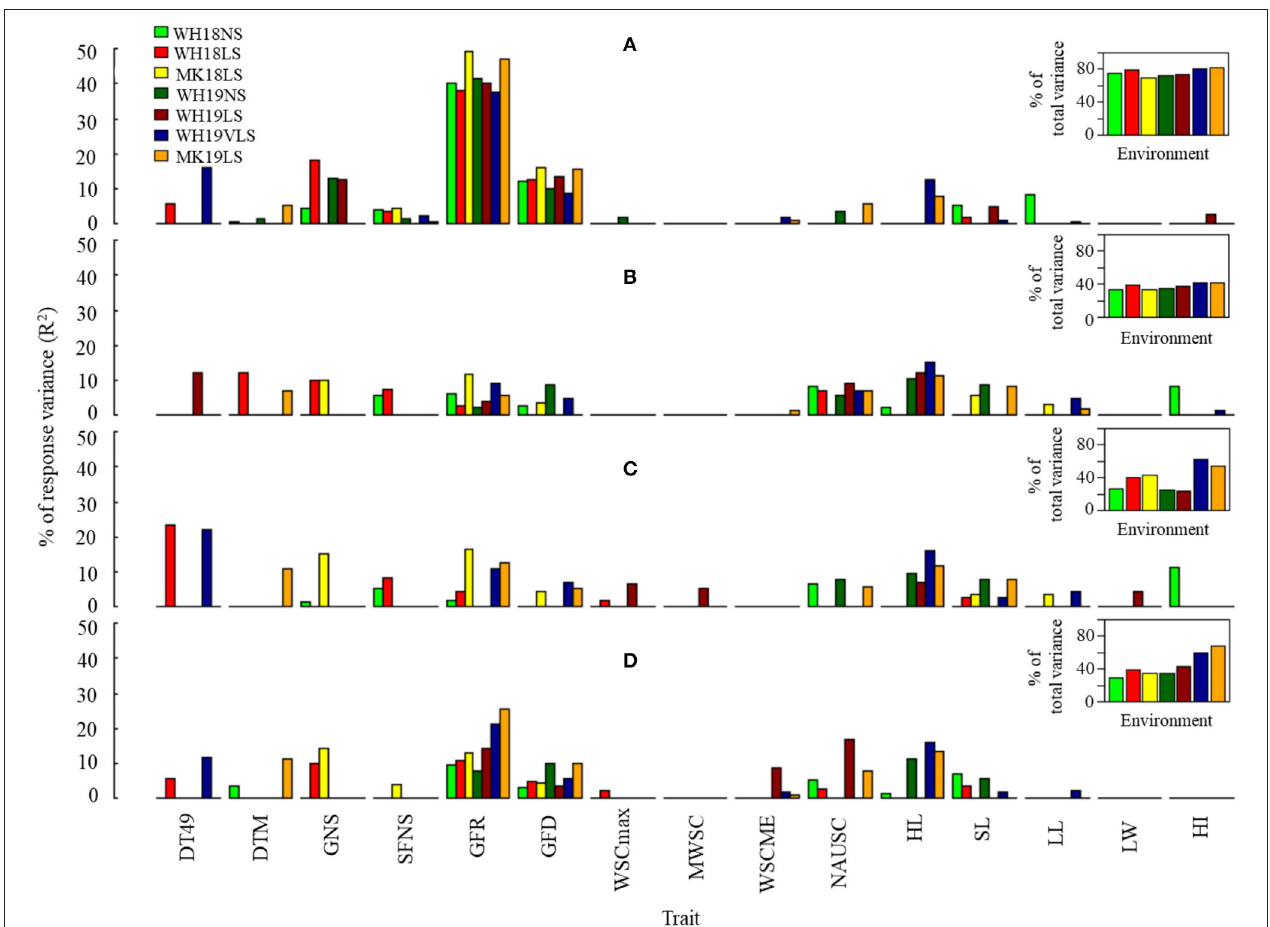
FIGURE 4 | Estimated contribution (% of variance, R 2 ) of selected phenological, agro-morphological and physiological traits to (A) TGW, (B) GP, (C) Ret, and (D) grain width (GWi) in WH18NS (light-green), WH18LS (light-red), MK18LS (yellow), WH19NS (dark-green), WH19LS (dark-red), WH19VLS (navy-blue), and MK19LS (orange) environments. Insets show the total variability explained by the best significant model in each environment ( p < 0.0001 ). Environment and trait definitions are as defined for Tables 1 , 2 ,